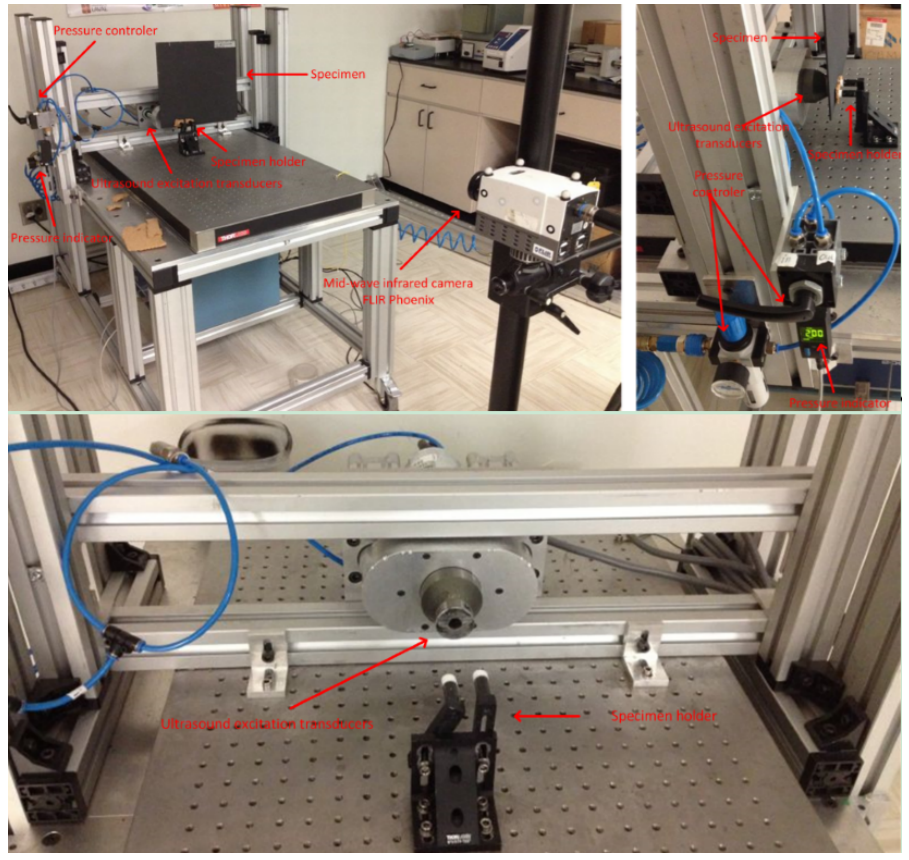
Figure 6. The vibrothermography experimental setup.